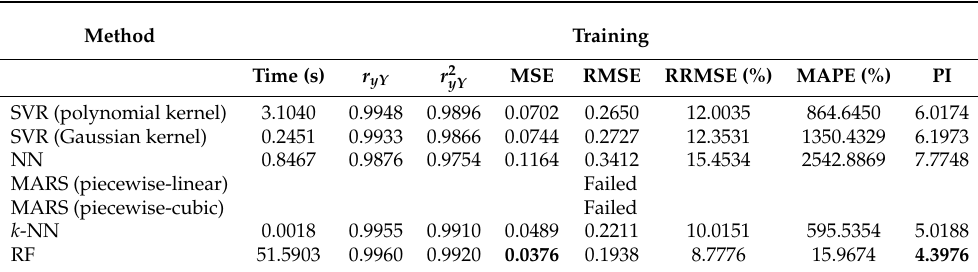
Table 16. Performance of machine learning in prediction of carbon based on dynamic data. Method